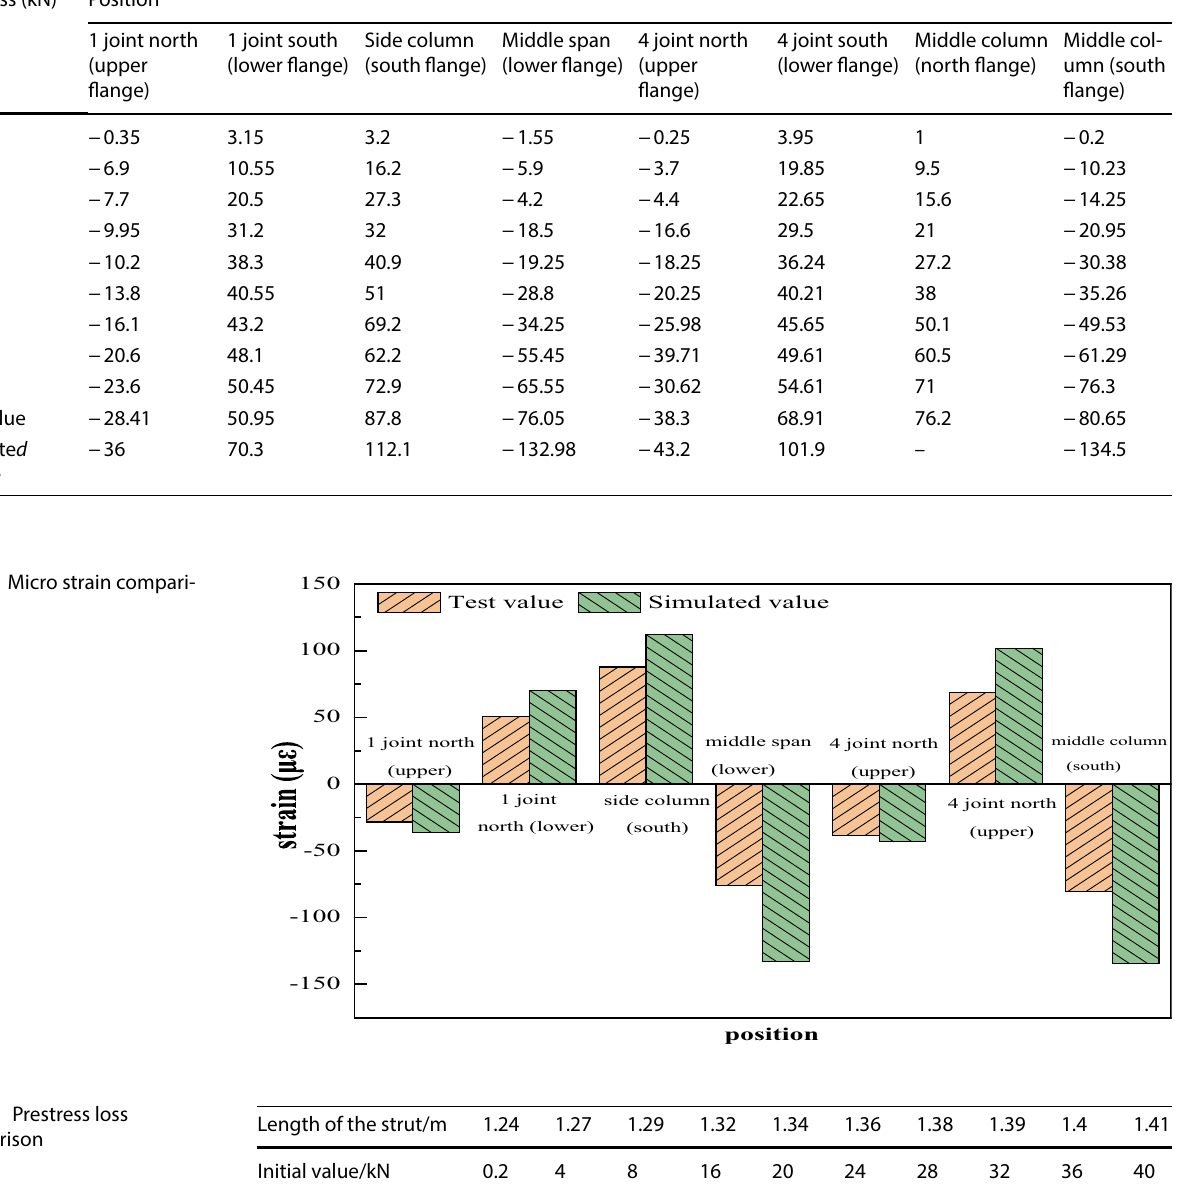
Table 2 Comparison of strain results ( μ ε)